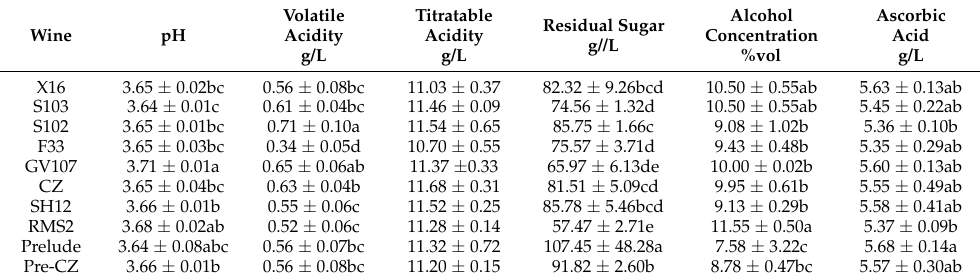
Values in the same column with different lowercase letters are significantly different ( p ≤